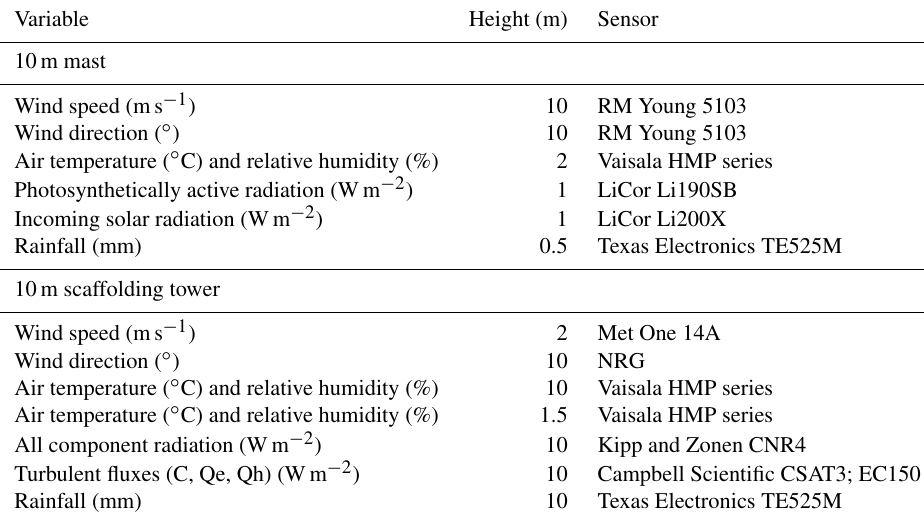
Table 1. Long-term meteorological instrumentation at St. Denis National Wildlife